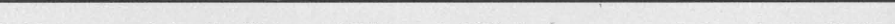
Table 3. Estimates of the Coefficient of Dispersal (CD) for surveys carried out in the Gulf of Bothilla 1988-1996. The CD is calculated as CD=variance/mean. Values close to 1 show that sam- ples are essentially Poisson, whereas values exceeding 1 indicate clumped samples and values be- low 1 repulsion (Sokal and Rohlf 1981). The "n" indicates sample size ( number of segments) and the "mean" the average density of seals in samples. For 1996, data are shown for high and low density areas (see text) separately and for the entire area. The inverted value of the variance (1/ S2) is used for weighing the linear regression in Fig.